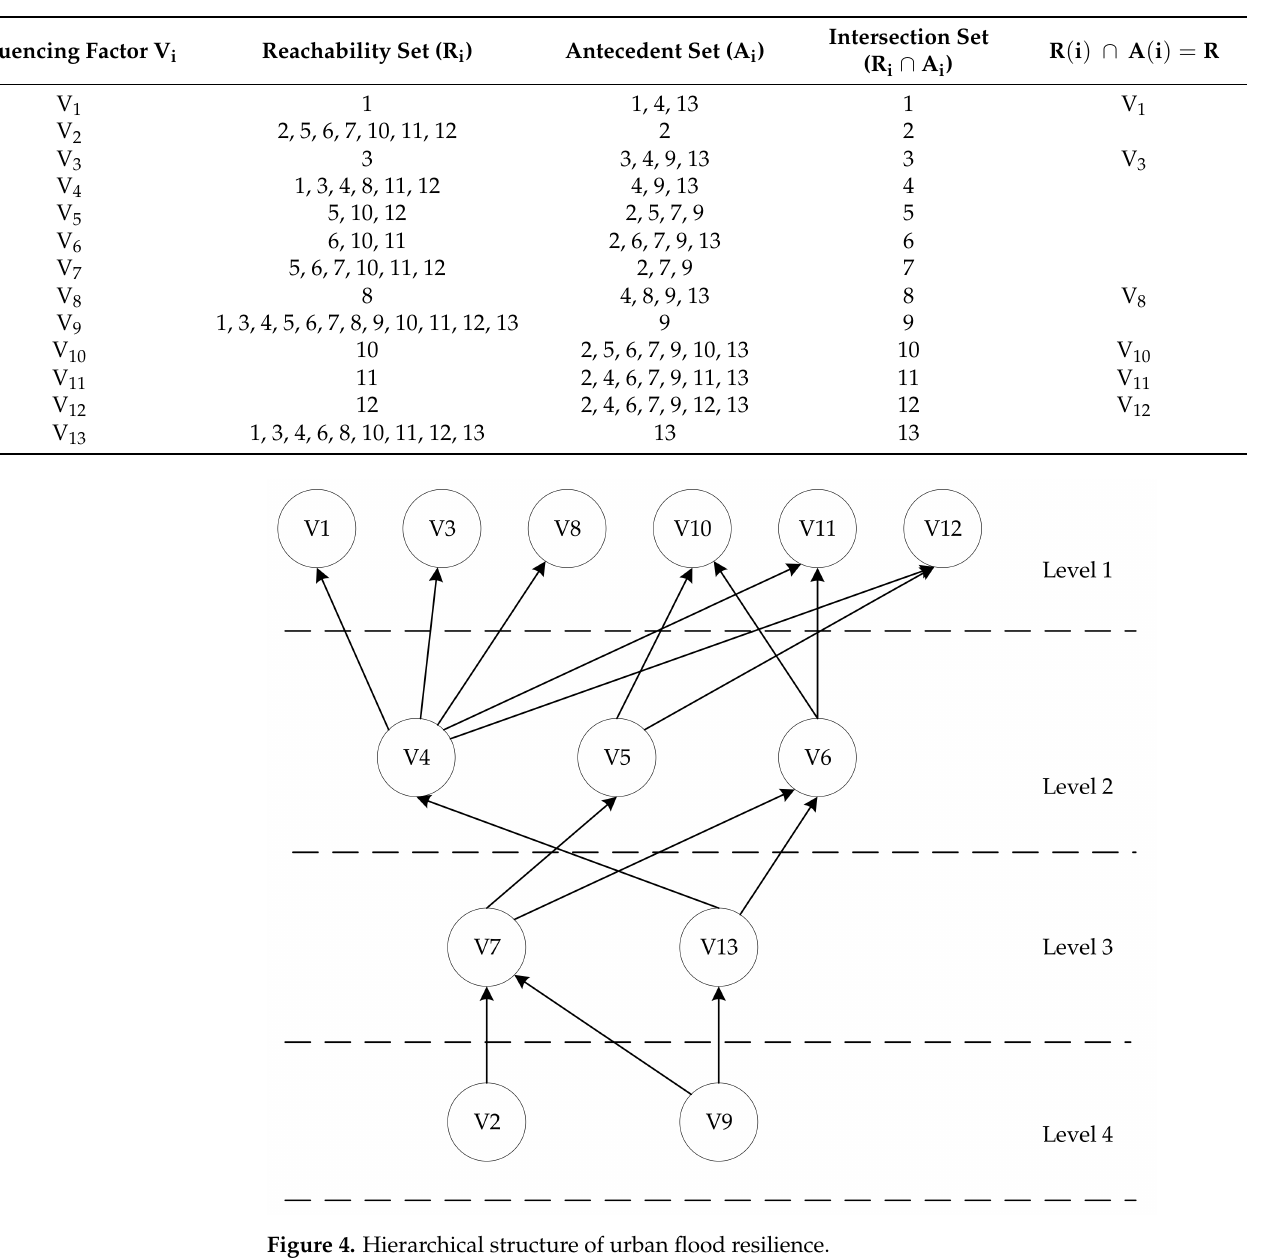
Table 4. First-level factor division data.